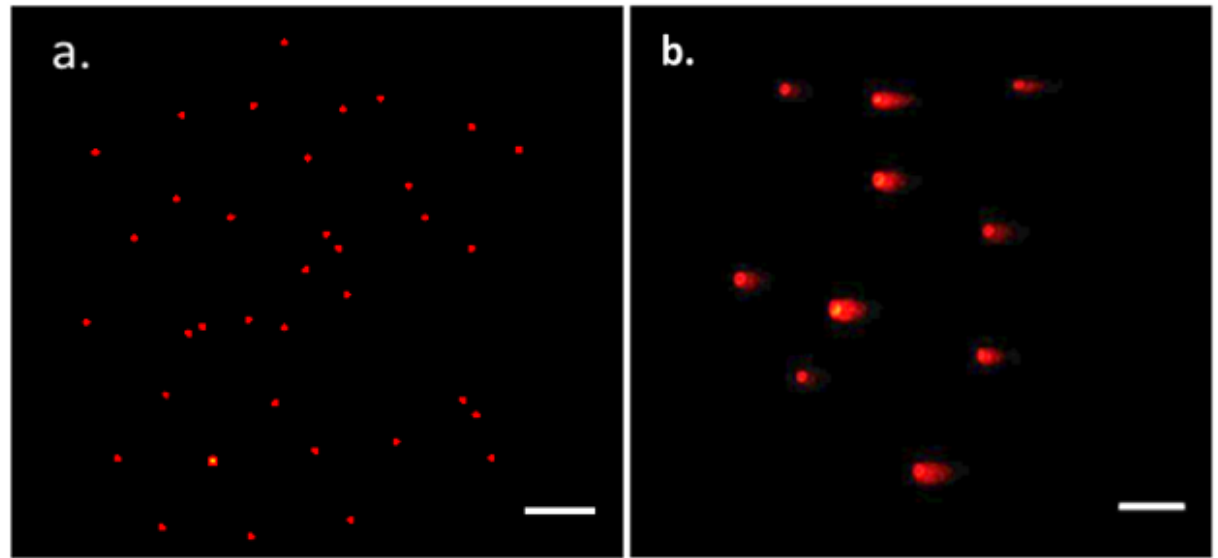
Figure 11. DNA fragmentation studies of PTAgNPs. ( a ) Control; ( b ) treated.